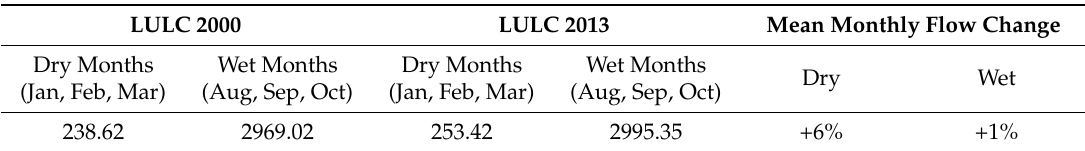
Table 8. Mean Monthly Flow.